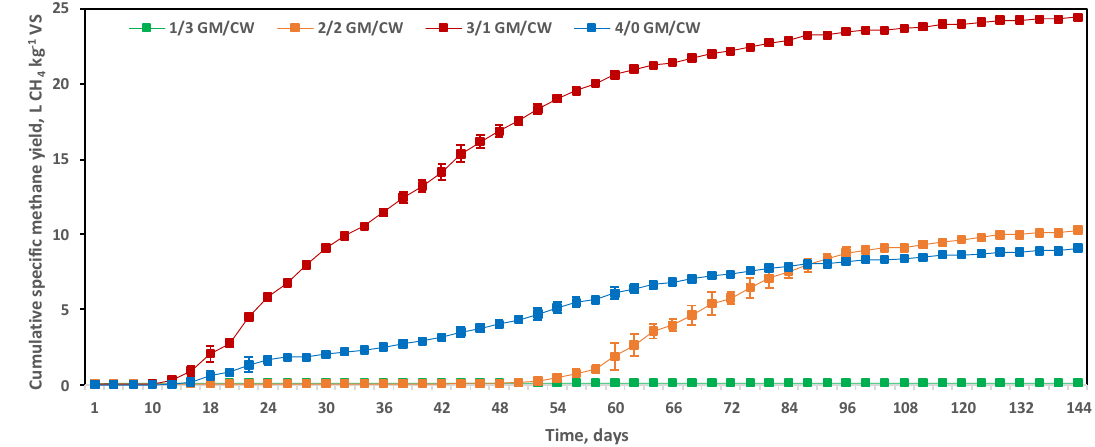
Figure 2. Cumulative methane production (L CH 4 kg −1 VS) in digesters containing 1/3 GM/CW ( w / w ) [green]; 2/2 GM/CW ( w / w ; orange); 3/1 GM/CW ( w / w ; red); and 4/0 GM/CW ( w / w ; blue) at 55 °C. Values reported as mean ± standard error.